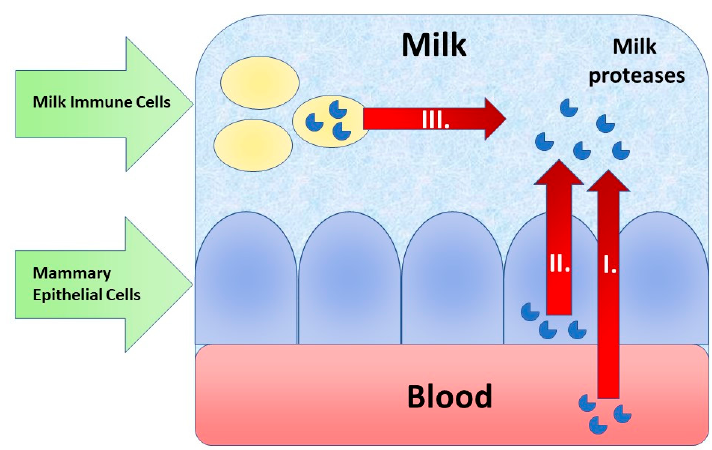
Figure 1. Three main routes of protease infiltration into milk. (I) Proteases from the blood pass the vessel and through the epithelial cells into milk. (II) Proteases can be secreted by mammary epithelial cells. (III) Proteases are released by milk immune cells.